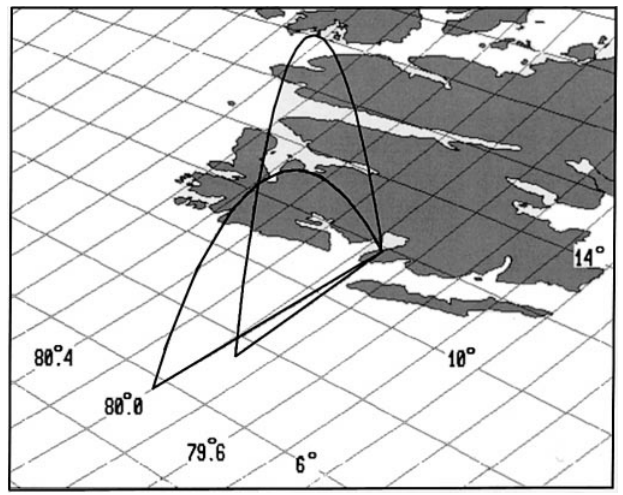
Fig. 2. The nominal ( high apogee ) and the actual ( low apogee ) payload trajectories. The rocket was launched towards the west from Ny-A ˚ lesund (the azimuth angle was 276 (cid:176) from